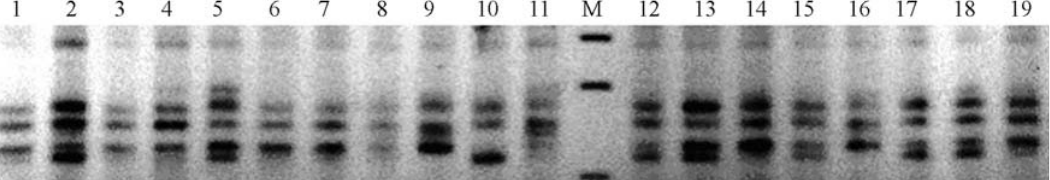
Figure1 -SimplesequencerepeatvariationattheAFca16locusofsomeindividualAlfanafaplants.Theletter‘M’denotesthemolecularmarker,147bp, 110 bp and 90 bp from top to bottom of the